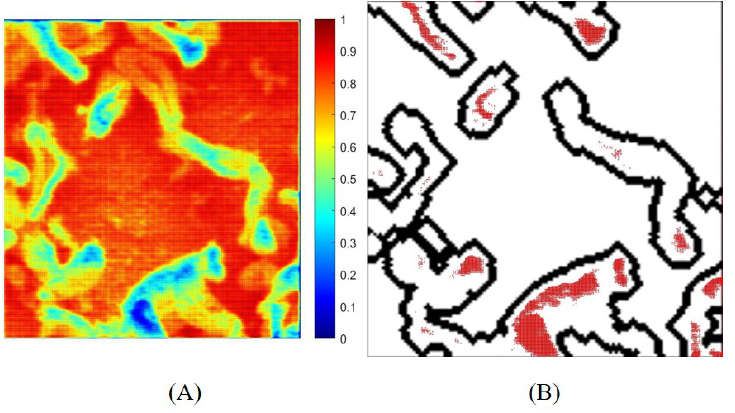
Figure 9. ( A ) Heatmap of confidence entropy values, ( B ) view of the pseudo label before replacement with pixels (in red) to be annotated by